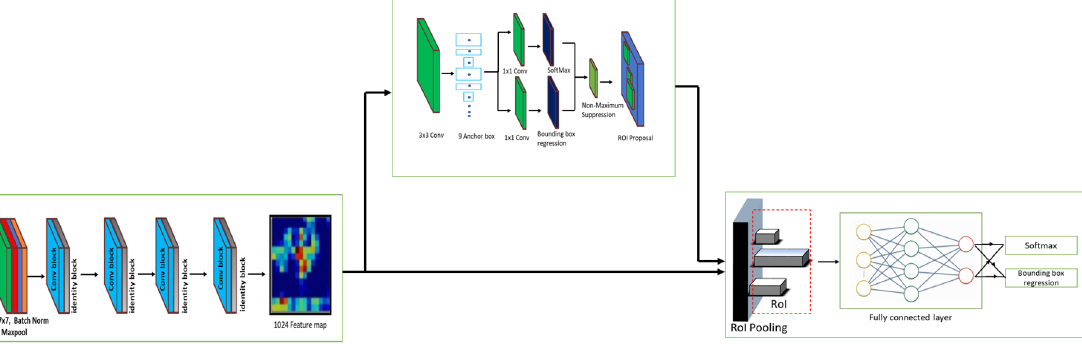
Figure 2. Faster Region-based Convolutional Neural Network (RCNN) RestNet